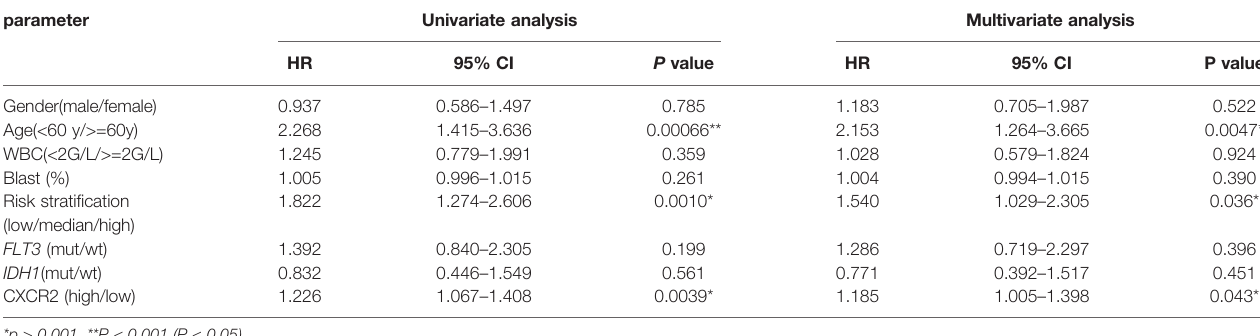
TABLE 2 | Univariate and multivariate overall survival (OS) analysis of CXCR2 in AML patients.